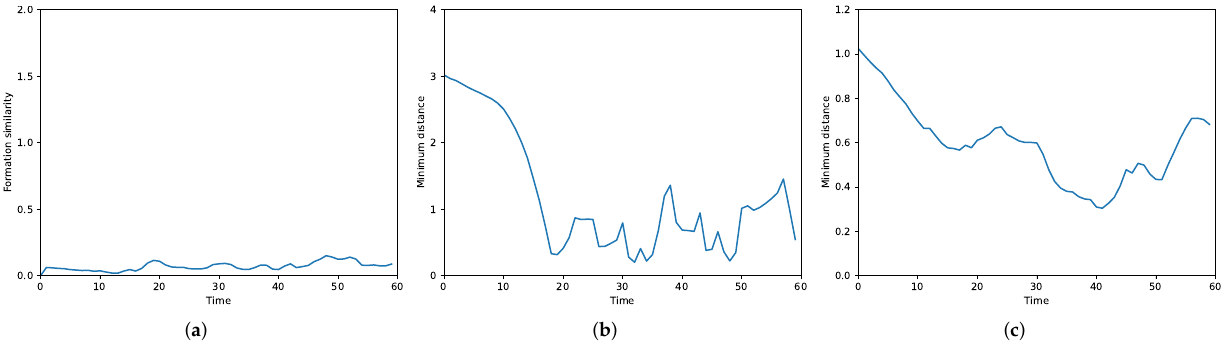
Figure 7. Illustration of the performance of interaction terms for MFG control ( F 1 , F 2 , F 3 ). ( a ) For- mation similarity error. ( b ) Minimum distance between UAVs and obstacles. ( c ) Minimum distance between